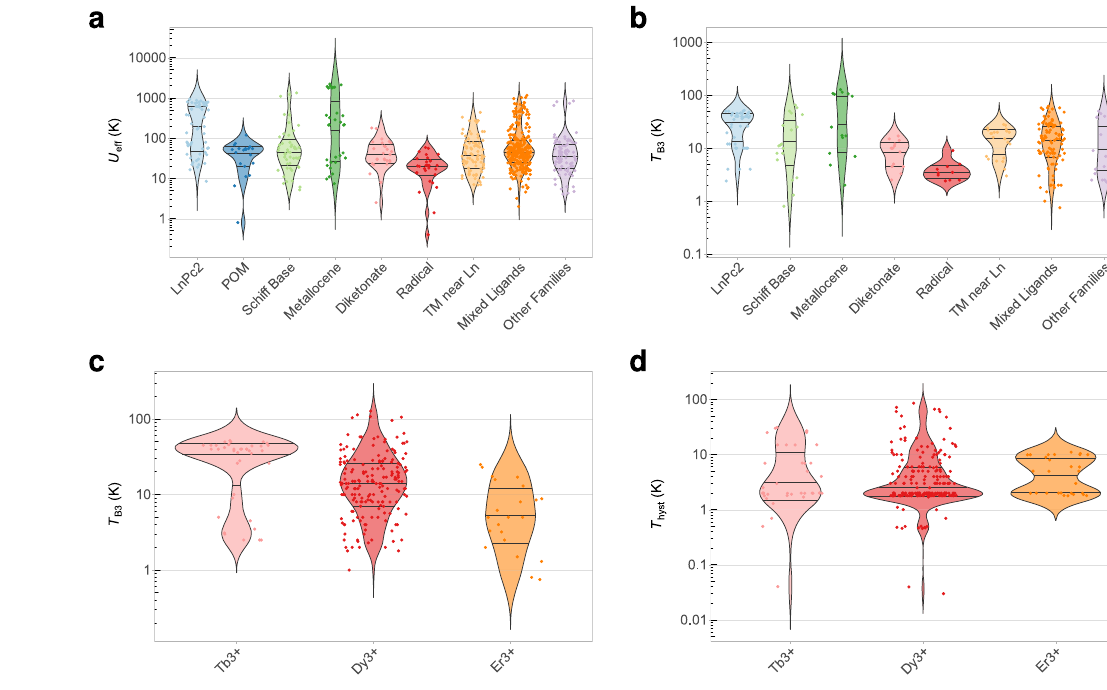
the quartiles. a Values of U eff for samples in each chemical family. b Values of T B3 for samples in each chemical family. c Values of T B3 for samples containing Tb 3+ , Dy 3+ , Er 3+ . d Values of T hyst for samples containing Tb 3+ , Dy 3+ , Er 3+